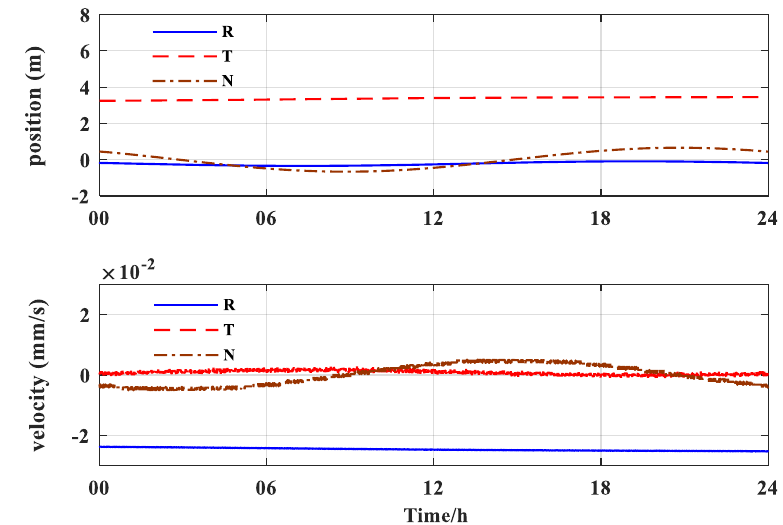
Figure 5. Orbit overlap difference using GPS broadcast ephemeris.